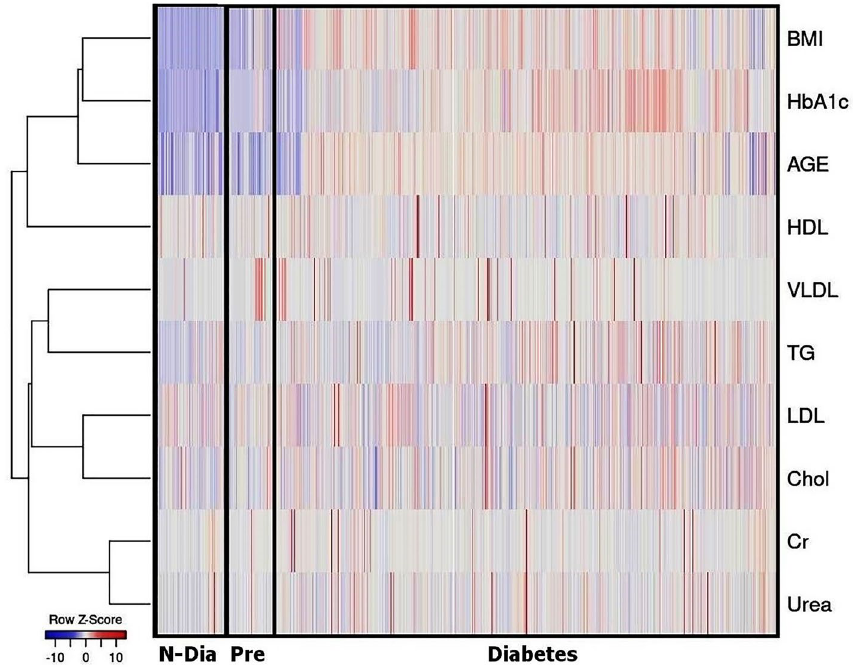
Figure 1. The heatmap of the blood biochemical markers, age, BMI across various groups. Heatmap was generated by “Heatmapper web tool”. The heatmap was created using the Pearson distance measure. Red represents higher values. Blue represents smaller values. The color intensity indicates the variation of the values in the color scale on the left side of the heatmap. Dia diabetes, Pre pre-diabetes, N-Dia non-diabetes, Cr creatinine, Chol cholesterol, TG triglyceride, BMI body mass